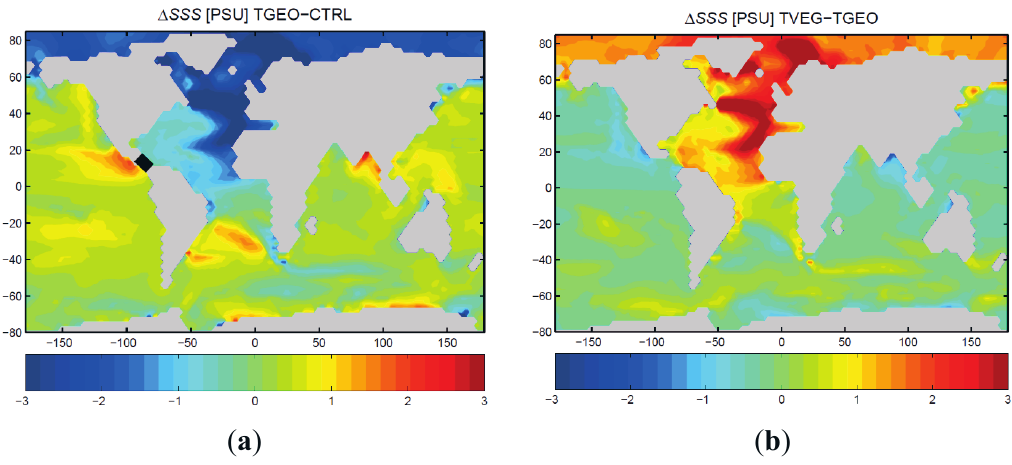
Figure 11. Modeled sea surface salinity anomalies [PSU]. ( a ) Difference between TGEO and CTRL; ( b ) difference between TVEG and TGEO.